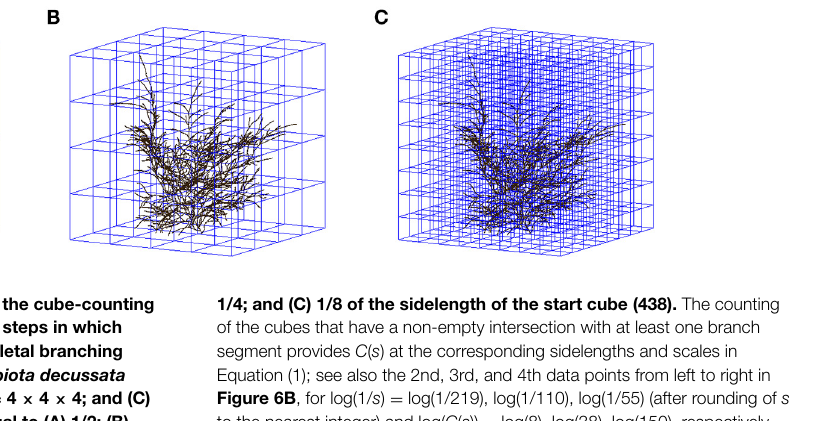
1/4; and (C) 1/8 of the sidelength of the start cube (438). The counting of the cubes that have a non-empty intersection with at least one branch segment provides C ( s ) at the corresponding sidelengths and scales in Equation (1); see also the 2nd, 3rd, and 4th data points from left to right in Figure 6B , for log(1/ s ) = log(1/219), log(1/110), log(1/55) (after rounding of s to the nearest integer) and log( C ( s )) = log(8), log(38), log(150),